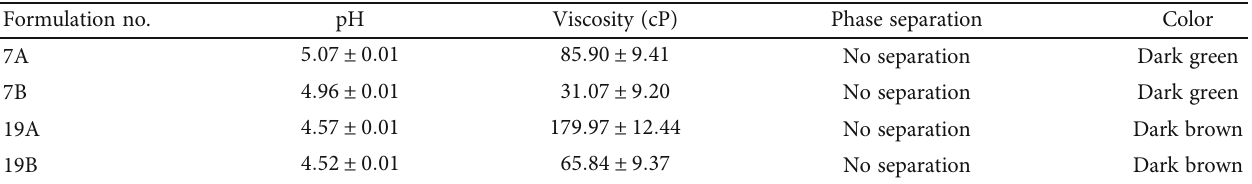
Table 6: pH values, viscosities, phase separation, sediment volumes, and colors of developed nail lacquers after six cycles of heating/cooling treatment.